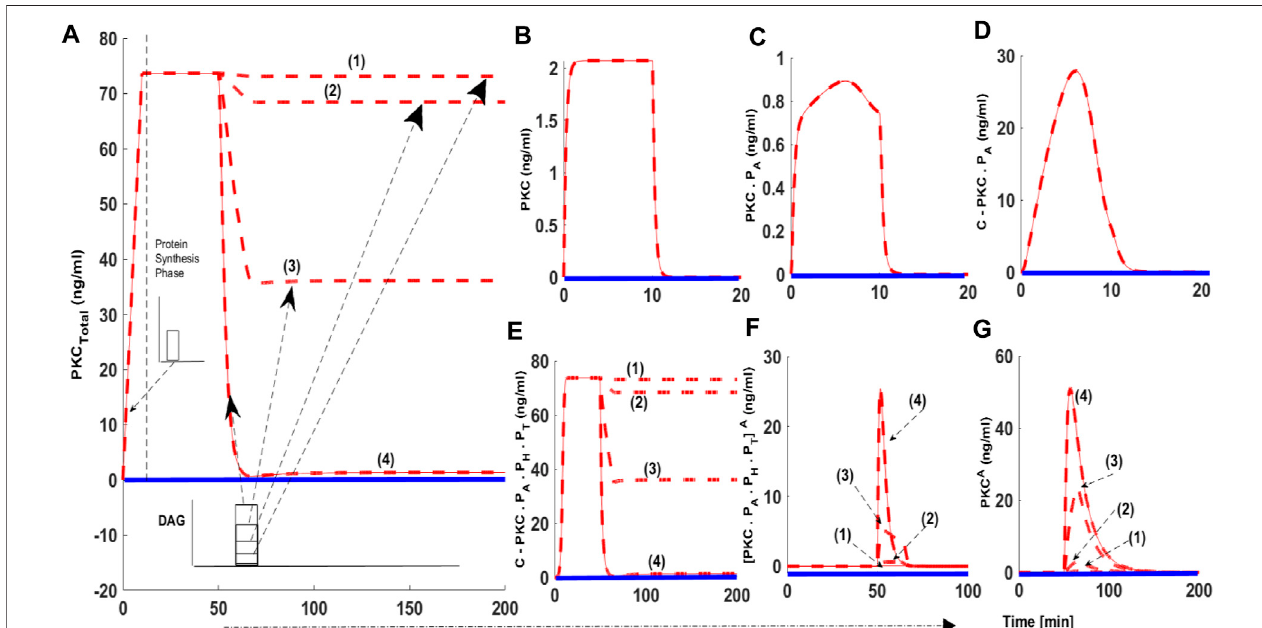
FIGURE2| Thenumericalsimulationsillustratingtheroleofproteinsynthesisandsecondmessenger-mediatedactivationoncPKClifecycle.Theseresultsindicate that initial application of a 10-min protein synthesis pulse leads to the generation of a naïve, and unstable enzyme which through constitutive phosphorylation events at the activation, turnand hydrophobic sitesattains stable state. Here,dashed red lines indicatestimulation(protein synthesis aswellassecond messenger) and blue solid line indicate non-stimulated conditions. (A) Total PKC enzyme during protein synthesis and second messenger mediated stimulation. (B) concentration of naïve, newly synthesized unstable form of cPKC. (C) concentration of PKC species phosphorylated at activation site. (D) concentration of PKC complex C. PKCP A . (E) concentration of PKC complex, phosphorylated at all three sites i.e., activation, turn and hydrophobic sites. These results show that complex C.PKC.P A .P H .P T is downregulated by higher stimulation levels of second-messenger DAG. (F) concentration of active complex PKC. P A .P H .P T . A after second-messenger binding. Again, these results indicate that activation levels of this complex are dependent on the levels of second-messenger stimulation. (G) concentration of dephosphorylated but active PKC A